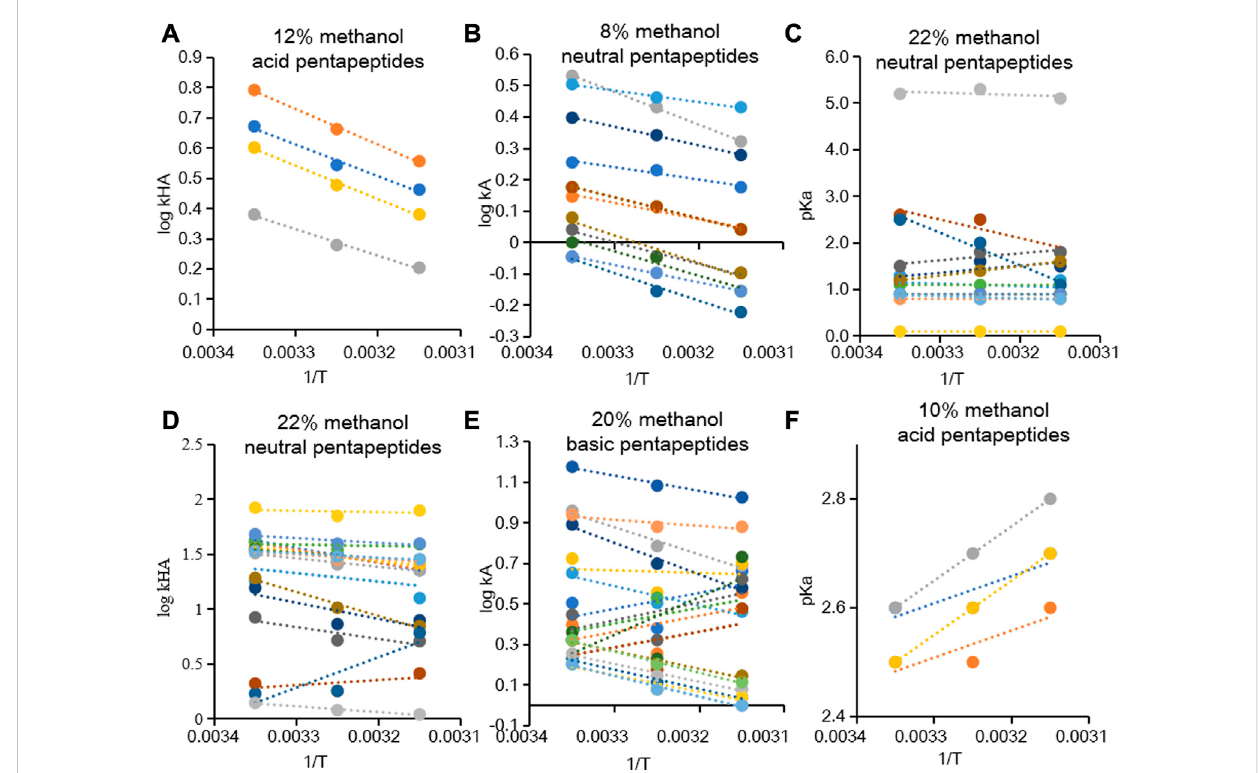
FIGURE 2 Dependenceof logk HA , logk A ,and pK a ofacidpentapeptidesin12%methanol (A) ,neutralpentapeptidesin8%methanol (B) ,neutralpentapeptidesin 22%methanol (C) ,neutral pentapeptides in22% methanol (D) ,basicpentapeptides in20%methanol (E) , andacidpentapeptidesin10%methanol (F) with respect to 1/ T